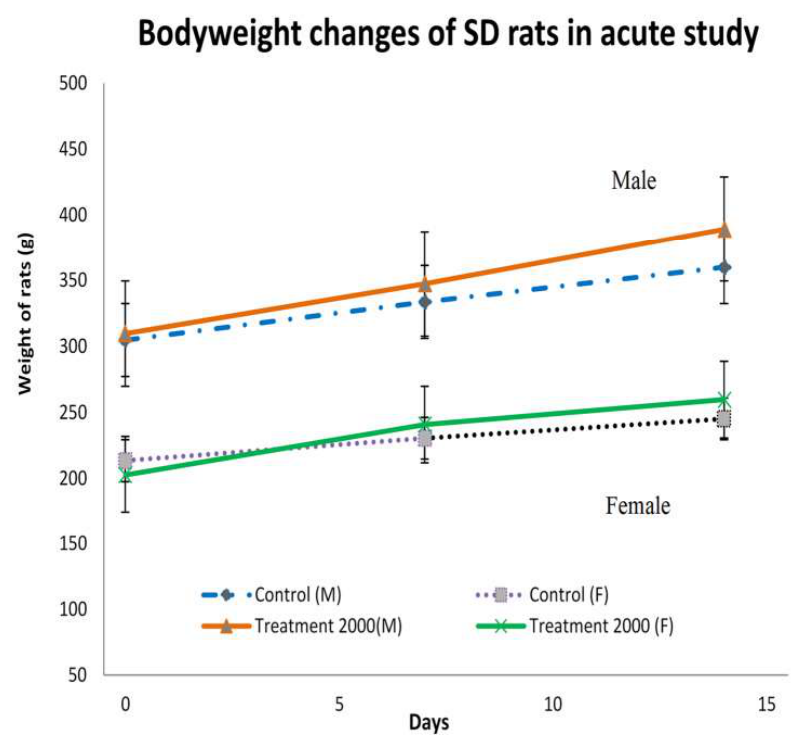
Figure 1. Average body weight gain for male (A) and female (B) rats treated by gavage with 0 mg kg −1 ( ♦ ) and 2000 mg kg − 1 (x) palm puree for 14 d during an acute toxicology study ( n = 6 animals (◊) and 2000 mg kg −1 (x) palm puree for 14 d during an acute toxicology study ( n = 6 animals per group). Data are means ± SD for groups of five animals/sex/dose.